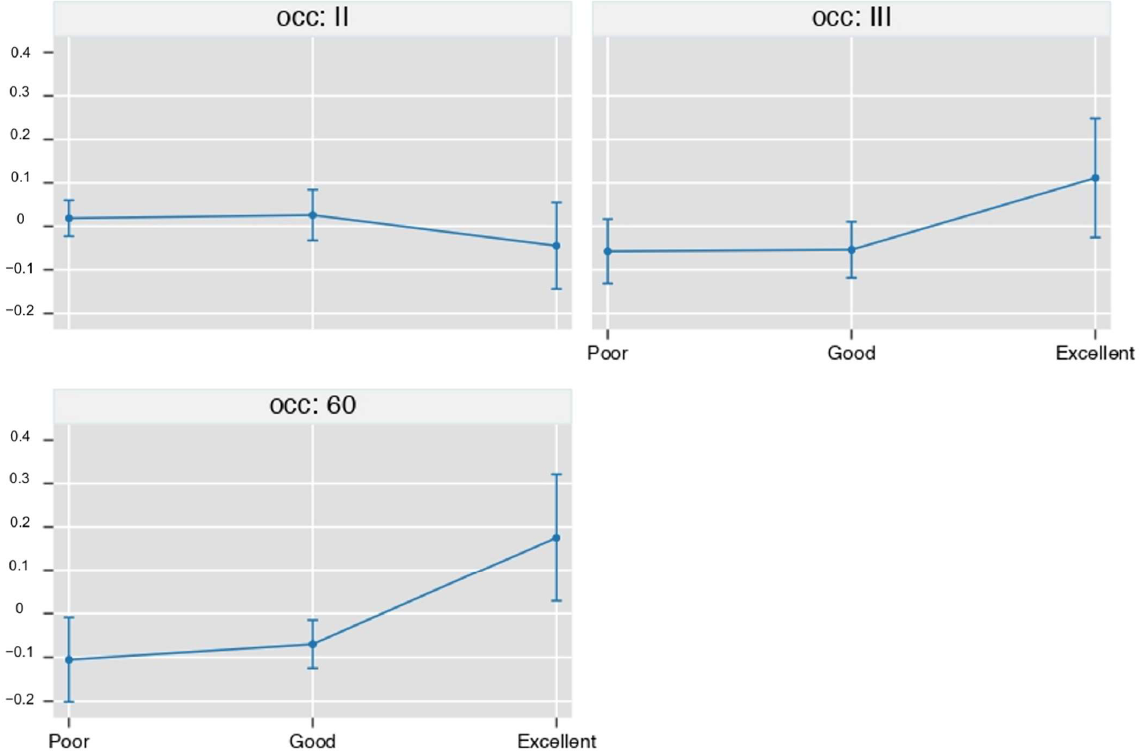
Figure 4. legend Between-group (O 2 -O 3 -ALA minus steroid) difference in the proportion of patients with a poor, good and excellent outcome during the study. Values are proportions and 95% cluster confidence intervals from ordinal logistic regression with Bonferroni correction for 9 contrasts. Points whose 95%CI do not cross the 0 line are significant at a p -level < 0.05 (see statistical analysis for details).